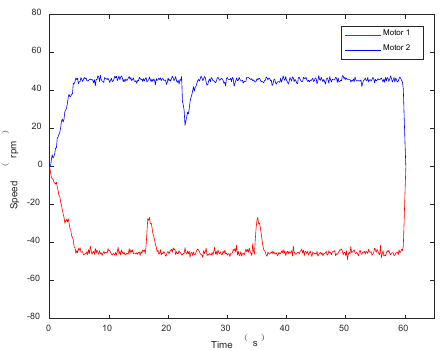
Figure 22. Rotation speed of motors.